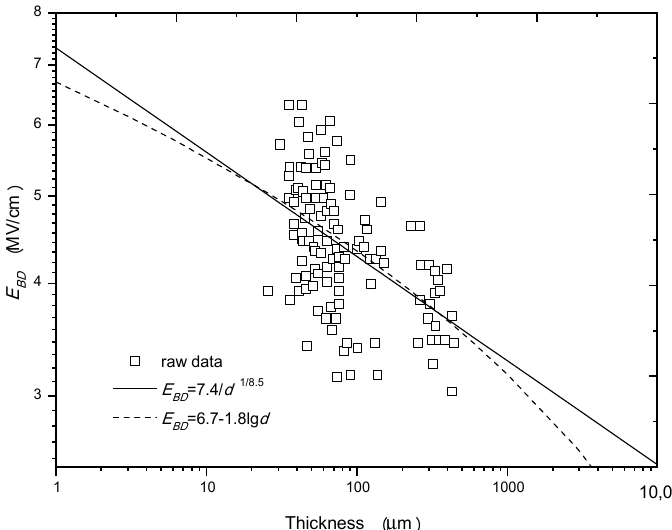
Figure 8. Comparison between the minus power relation and the minus-single-logarithm relation with the experimental data from Cooper in a log-log coordinate system.